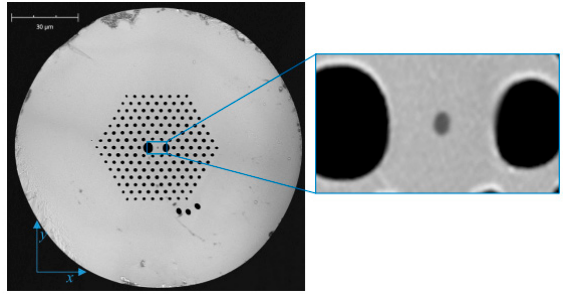
Figure 1. Scanning Electron Microscope (SEM) image of the birefringent microstructured optical fiber with boron-doped inclusion in the center of the core (darker spot) used for the fabrication of the in-line Mach-Zehnder interferometer.